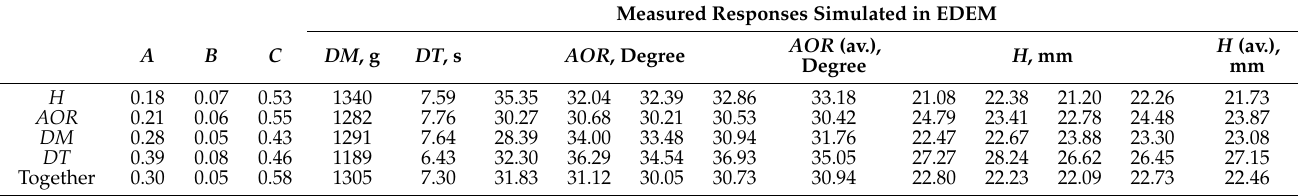
Table 6. The optimization results for considering all responses and individual